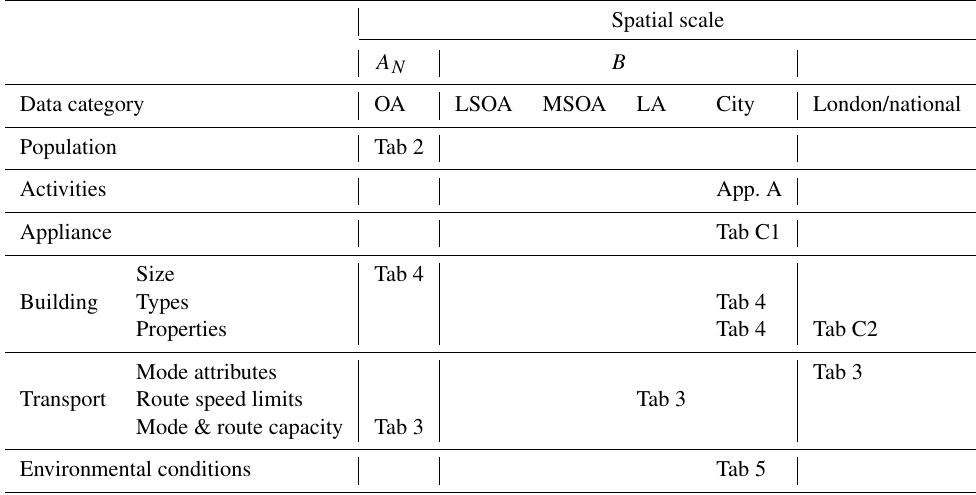
Table 1. Sources of data used by DASH and the highest spatial resolution (columns) used in Greater London. Details are given in the other tables (Tab) and appendices (App.) indicated. Notation defined in